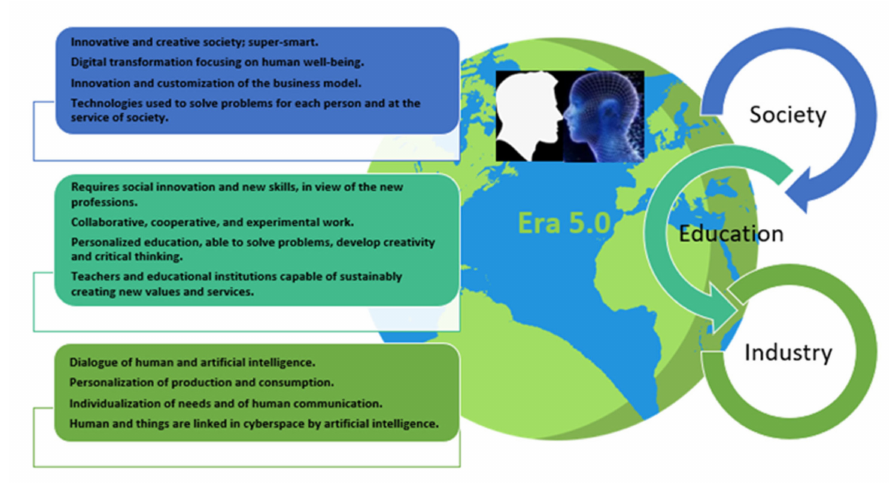
Figure 2. The paradigm of the new